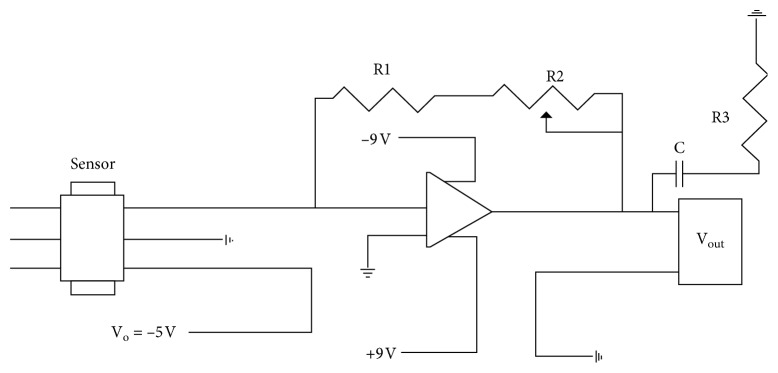
Conditioning circuit: R1 = 0.47 Ω; R2 = 20 KΩ; R3 = 10 Ω; C = 470 μF.